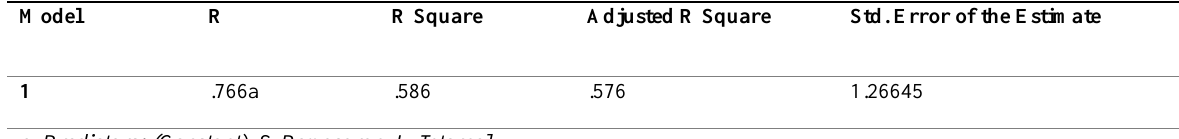
Table 2: Coefficient of Determination (R2) Model Structure II Model